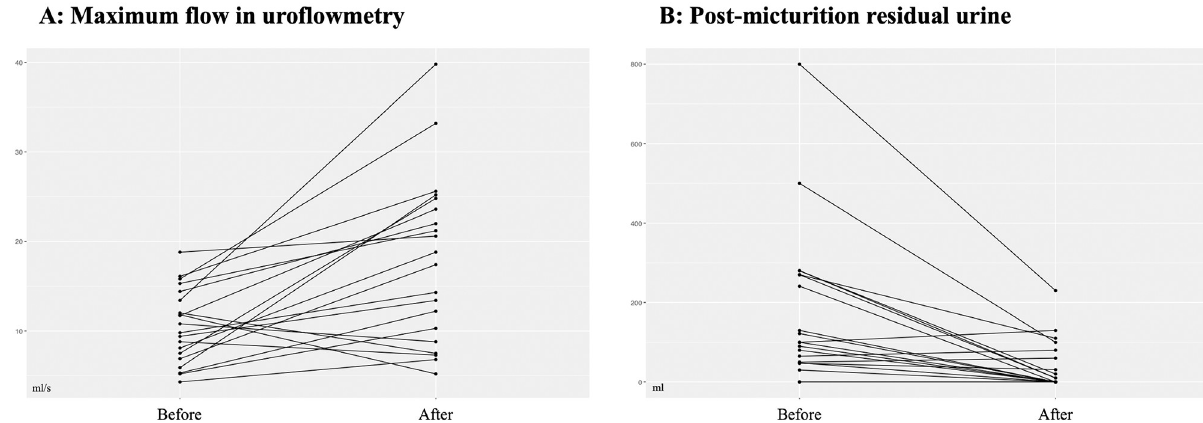
Fig 2. (A) Maximum flow (ml/s) in uroflowmetry before and after treatment (p = 0.003, n = 20). (B) Post-micturition residual urine (ml) before and after treatment (p = 0.007, n = 20).